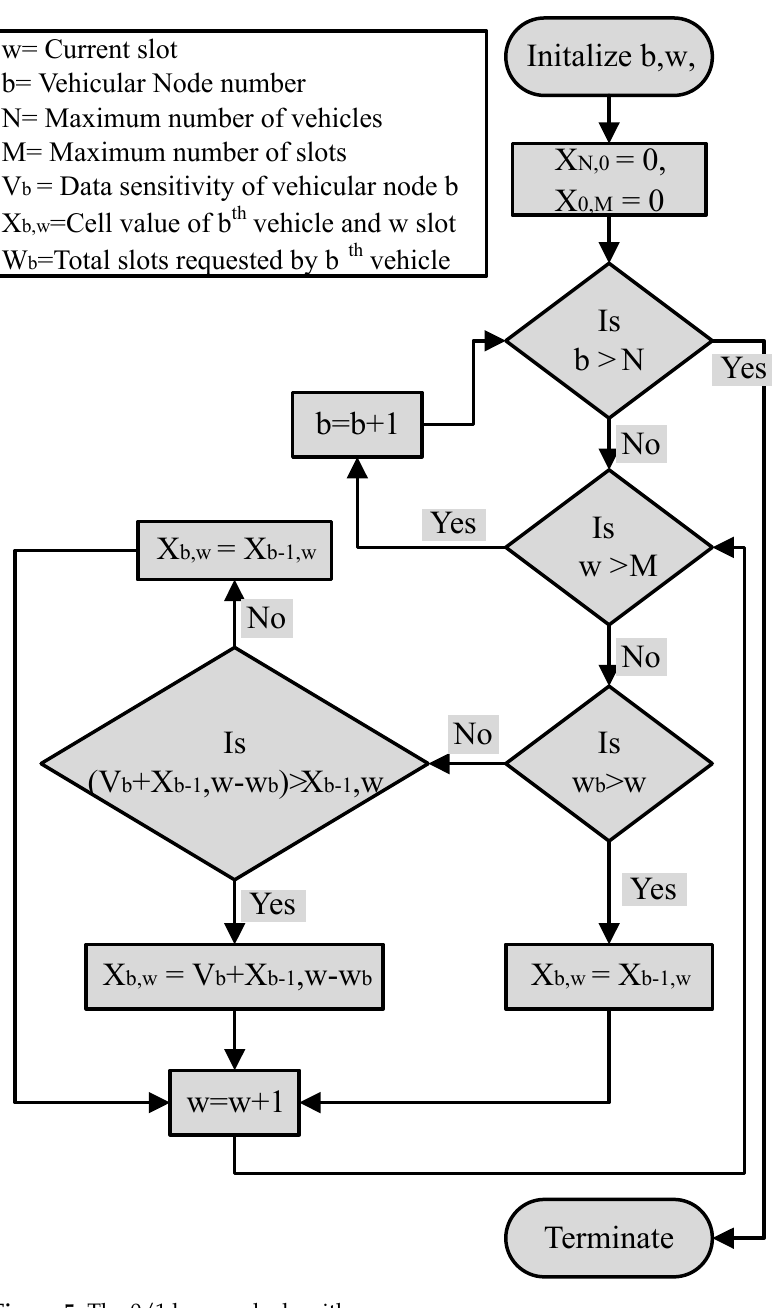
Figure 5. The 0/1 knapsack